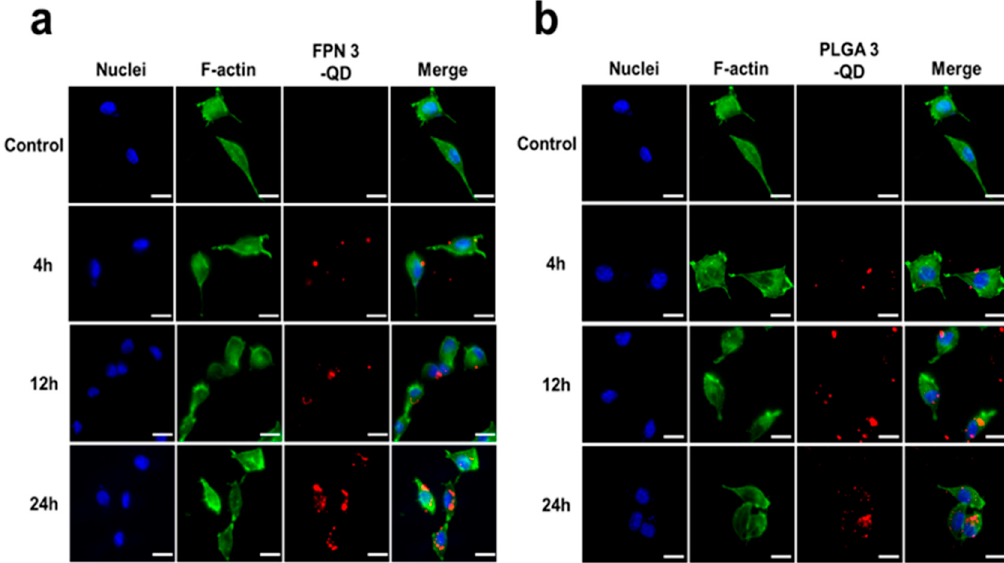
Figure 6. ( a ) Fluorescence images of cellular uptake of quantum dot-loaded FPN (FPN 3-QD) and ( b ) quantum dot-loaded PLGA particles (PLGA 3-QD) by MDA-MB-231 breast cancer cells at different times after feeding FPN 3-QD or PLGA 3-QD. Blue is DAPI for labeling the nuclei, green is phalloidin for labeling the cytoskeleton (F-actin), and red is the quantum dot from FPN 3-QD or PLGA 3-QD. (Scale bar: 20 μ m).